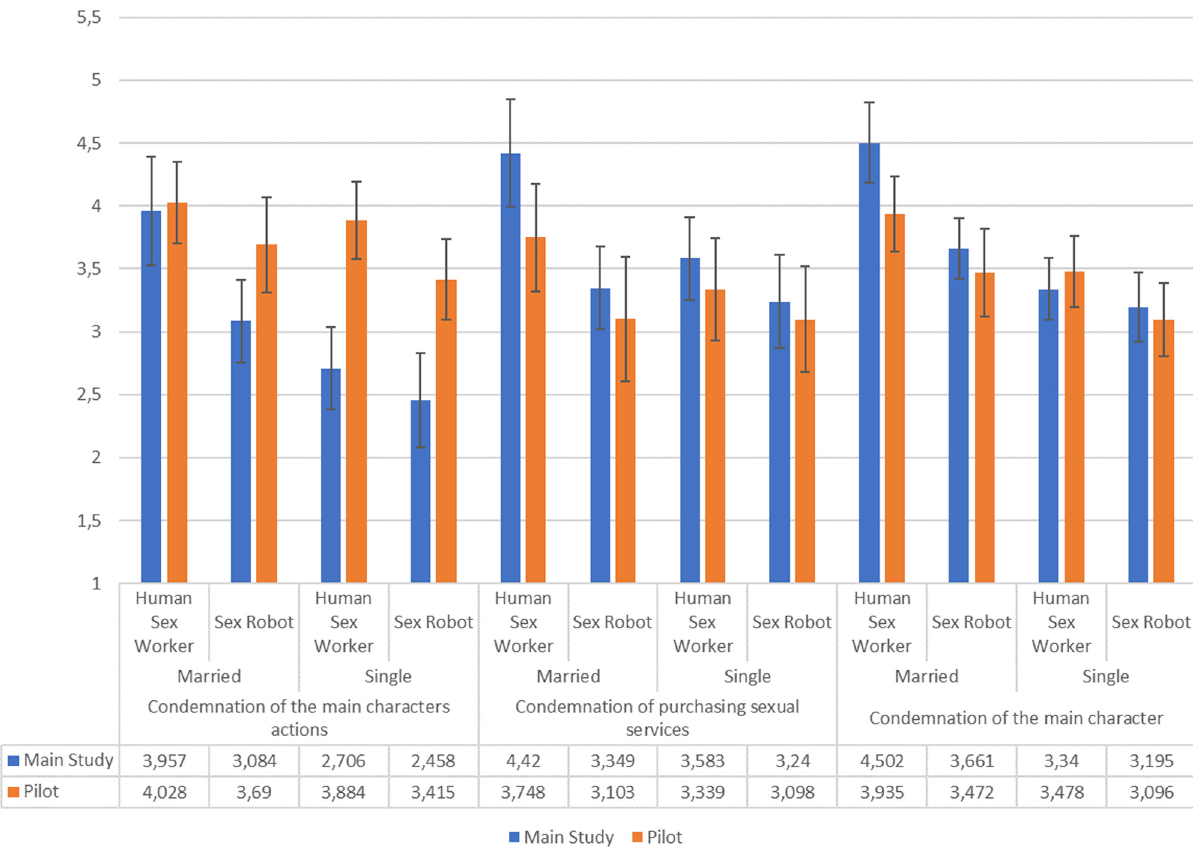
Figure 1: Mean values of DVs in di ff erent conditions in both